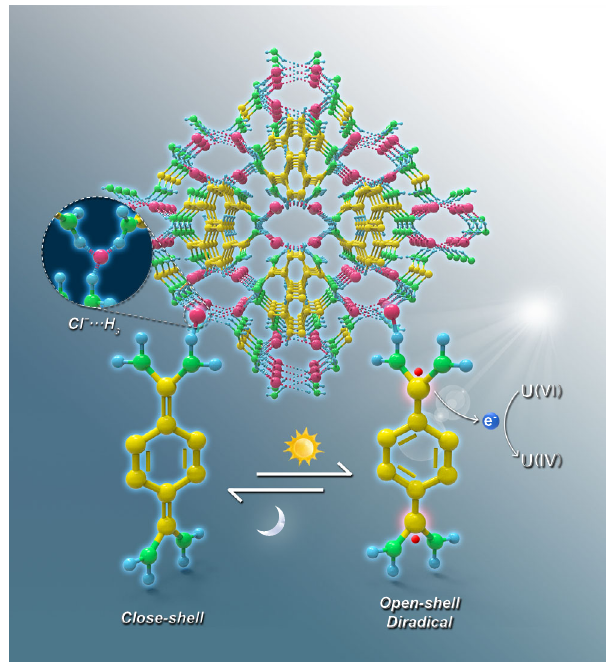
Fig. 6 Schematic diagram of the mechanism for photoreduction of U(VI) by XHOF-TAQ. The connection model for constructing the framework material is also